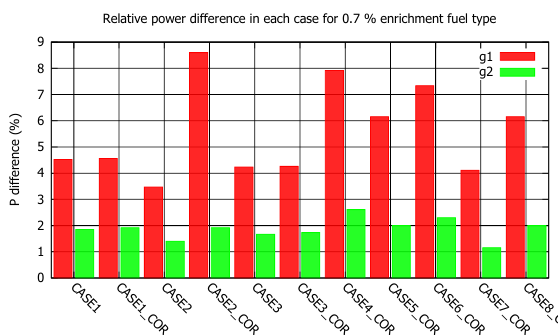
Figure 3. Relative power differences in the calcula- tion modes with 0.7% fuel enrichment test case